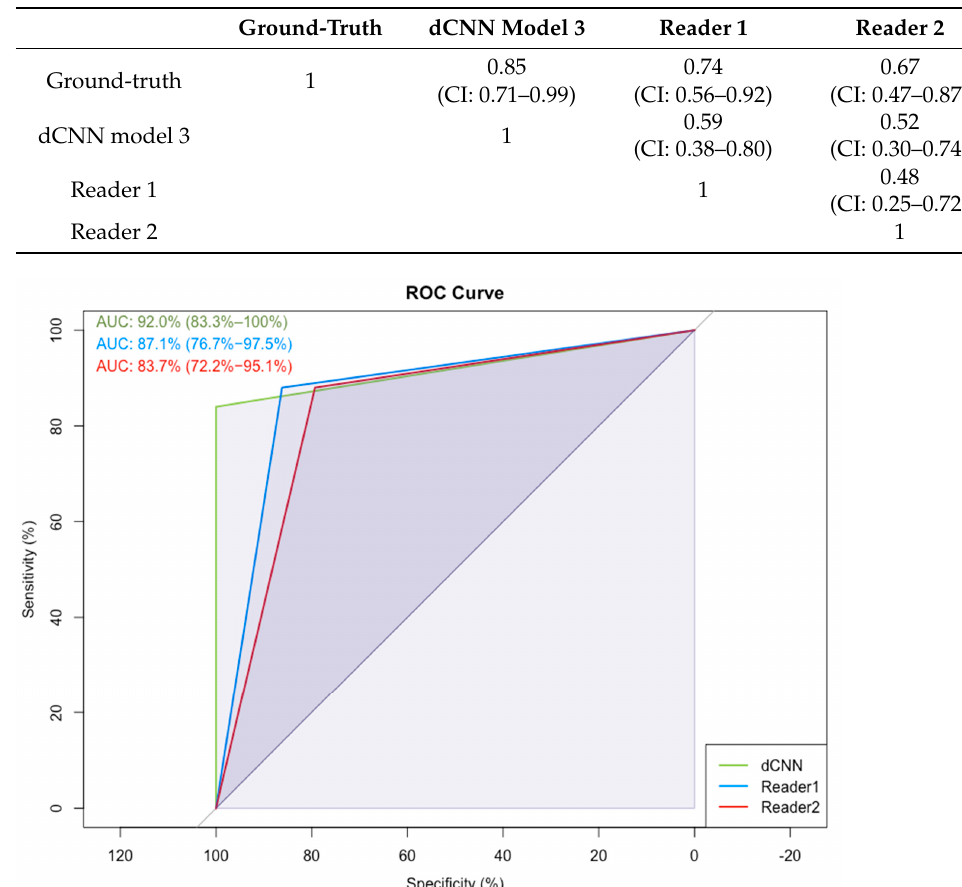
Table 4. Inter-reader reliability between dCNN model 3, both readers and the radiologists report (ground-truth). Kappa values of 0.81–1.0 were considered almost perfect, 0.61–0.80 as substantial and 0.41–0.60 as moderate agreement.